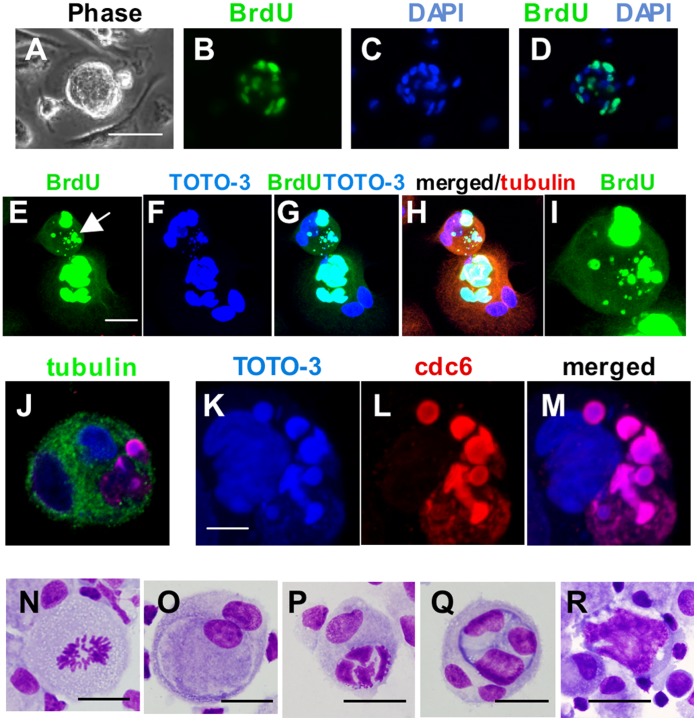
DNA synthesis and compartmentalization within multinucleated macrophages.(A-D) DNA synthesis, as evidenced by BrdU labeling, is occurring in multiple nuclei within a macrophage with nurse cell morphology. The phase contrast view (panel A) illustrates the nurse-like morphology of the living cell, prior to fixation. The culture was exposed to BrdU for 48 hours. (E-I) Confocal microscopy images demonstrating BrdU labeling in multinucleated macrophages. Culture was exposed to BrdU for 48 hours. Note that quiescent nuclei (blue only) are also present within both cells actively replicating DNA. Also apparent in the upper, somewhat smaller cell, are BrdU-labeled globular structures of multiple sizes. These colocalize with the DNA staining, confirming that they are active sites of DNA replication and not artifact. Panel I shows an enlarged view of this cell. (J-M) Confocal microscopy images demonstrating colocalization of expression of cell division cycle 6 (cdc6) protein with globular structures of DNA. Panels K-M are enlargements of the cell shown in Panel J. A gallery view of this cell is presented in Figure S5. (N-R) DNA configurations and compartmentalization in Wright’s- Giemsa stained cultured macrophages. Size bars: (A) 50 µm, (E) 20 µm, (K) 10 µm and (N) through (R) 25 µm.